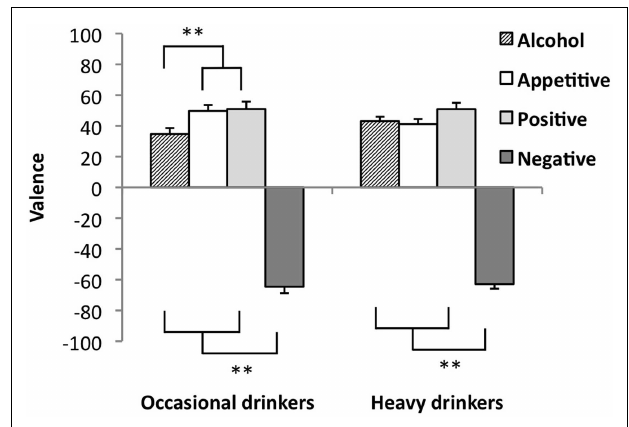
FIGURE 2 |Valence ratings of EP-AAT pictures for heavy ( n = 62) and occasional drinkers ( n = 48) . Pictures were rated on a scale from − 100 to 100. Mean valence scores are shown with standard error bars; ** p < 0.001.